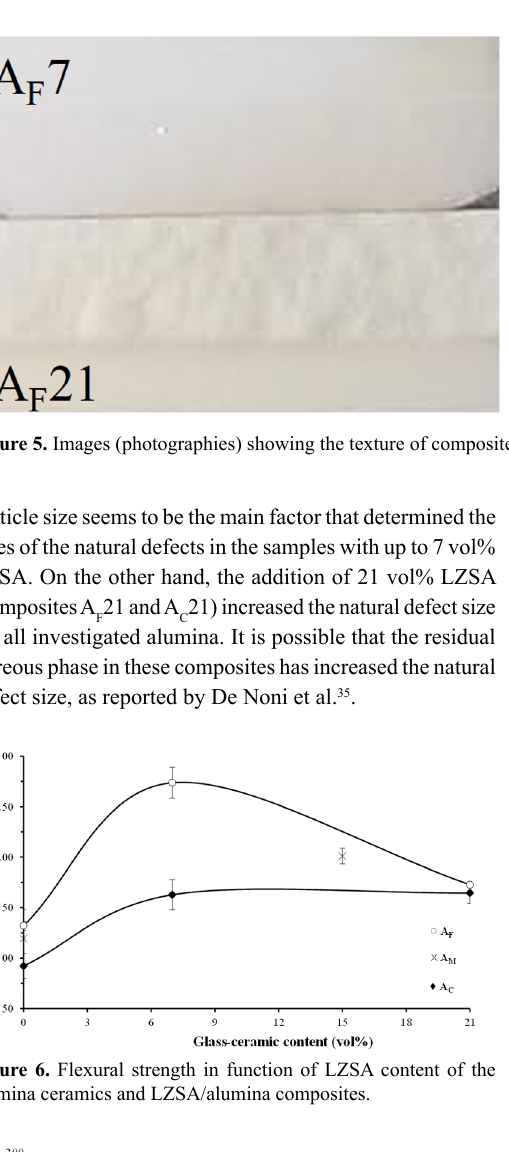
Figure 8. Partial XRD patterns of the alumina A A 7, A 21 and A F F C